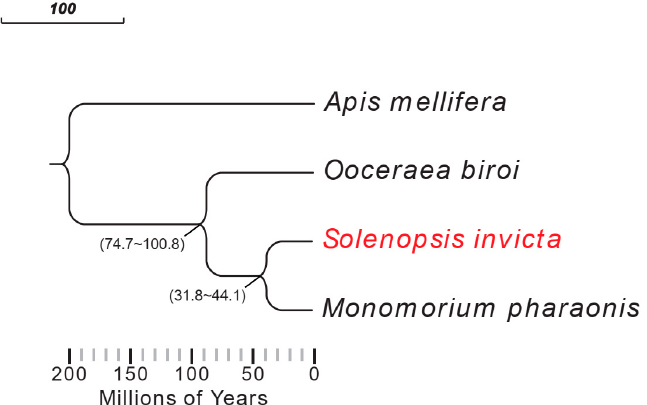
Figure 1. Phylogenetic tree of three Formicidae species. The phylogenetic tree was constructed with Orthofinder2 (version 2.5.4) using the longest transcripts of all genes. Apis mellifera were selected as an outgroup. O. biroi and S. invicta diverged between 74.7 and 100.8 million years ago, and S. invicta and M. pharaonis diverged between 31.8 and 44.1 million years ago.